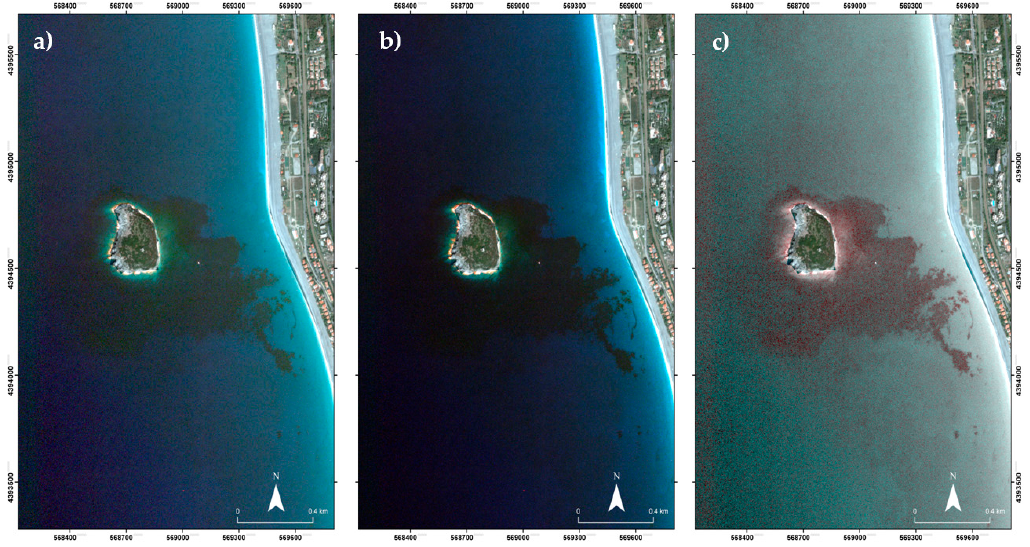
Figure 4. Pléiades image correction of the ( a ) True Color Image (TCI); ( b ) Pléiades image after Figure 4. Pl é iades image correction of the ( a ) True Color Image (TCI); ( b ) Pl é iades image after atmospheric correction; ( c ) Pléiades image after water column correction. atmospheric correction; ( c ) Pl é iades image after water column